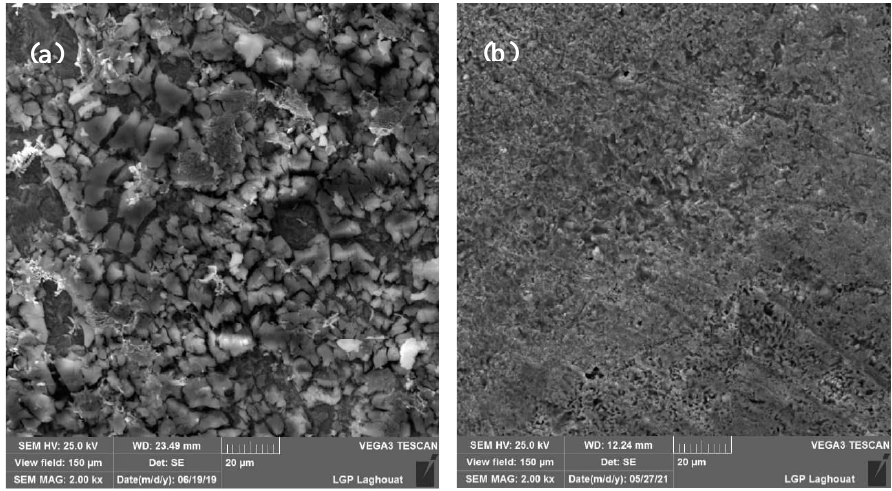
Fig. 6. SEM micrograph of corroded X52 steel after potentiodynamic polarization in 1M H 2 SO 4 solution: a) without boronizing, b) with